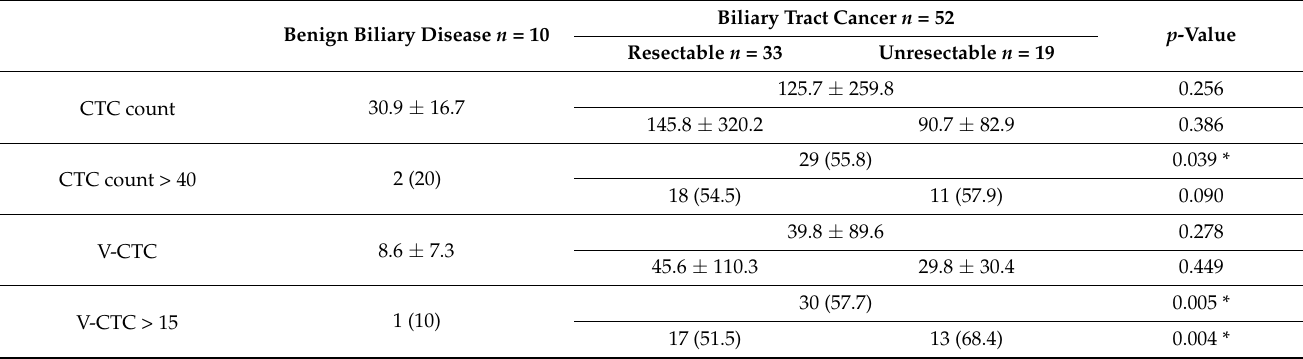
Table 2. CTC count and sensitivity and specificity of each parameter between benign and biliary tract cancer. Benign Biliary Disease n =